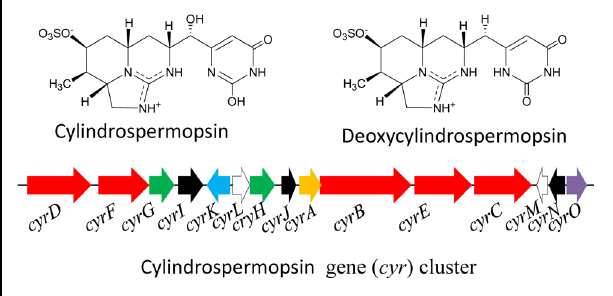
FIGURE 6 | Chemical structure of cylindrospermopsin and its biosynthetic gene ( cyr ) cluster in the cyanobacterium Cylindrospermopsis raciborskii AWT205. Red – PKS/NRPS, green – uracil ring, black – tailoring, blue – transport, white – transposase, orange – amidinotransferase, purple – regulator (Adapted from Mihali et al.,